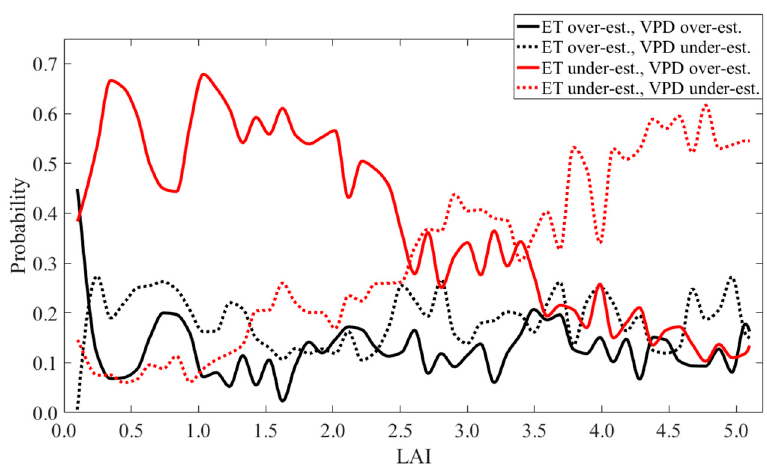
Figure 10. Probability of over- (black lines) or under-estimation (red lines) of ET LST with corresponding over- (solid lines) or under-estimation (dashed lines) of VPD as a function of daily LAI at AmeriFlux sites; note, black solid and red dashed lines represent direct relationships between ET LST and VPD errors while black dashed and red solids lines represent inverse relationships.